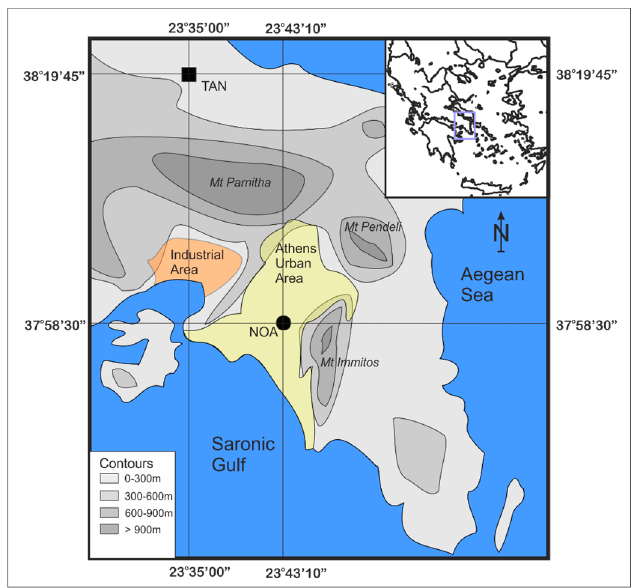
Figure 1. Location map of the greater Athens area. The urban meteorological station of Athens (NOA; operated by the National Observatory of Athens) and rural station of Tanagra (TAN; operated by the National Hellenic Meteorological Service) are indicated.